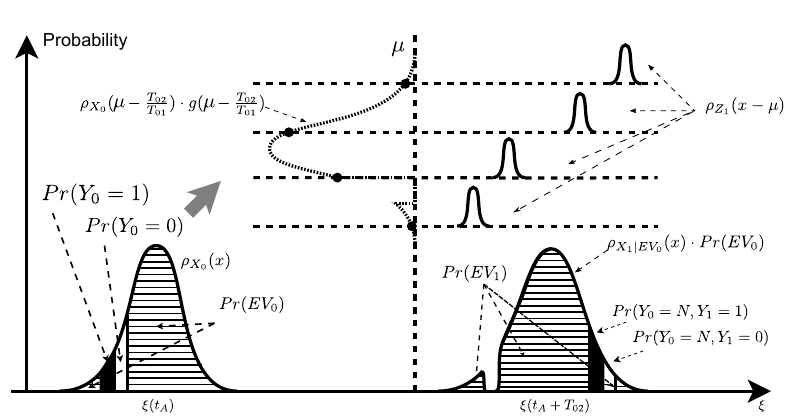
Figure 7: The intuitive interpretation of the first sample and the second sample. The formal derivation of Equation (30) can be found in Appendix